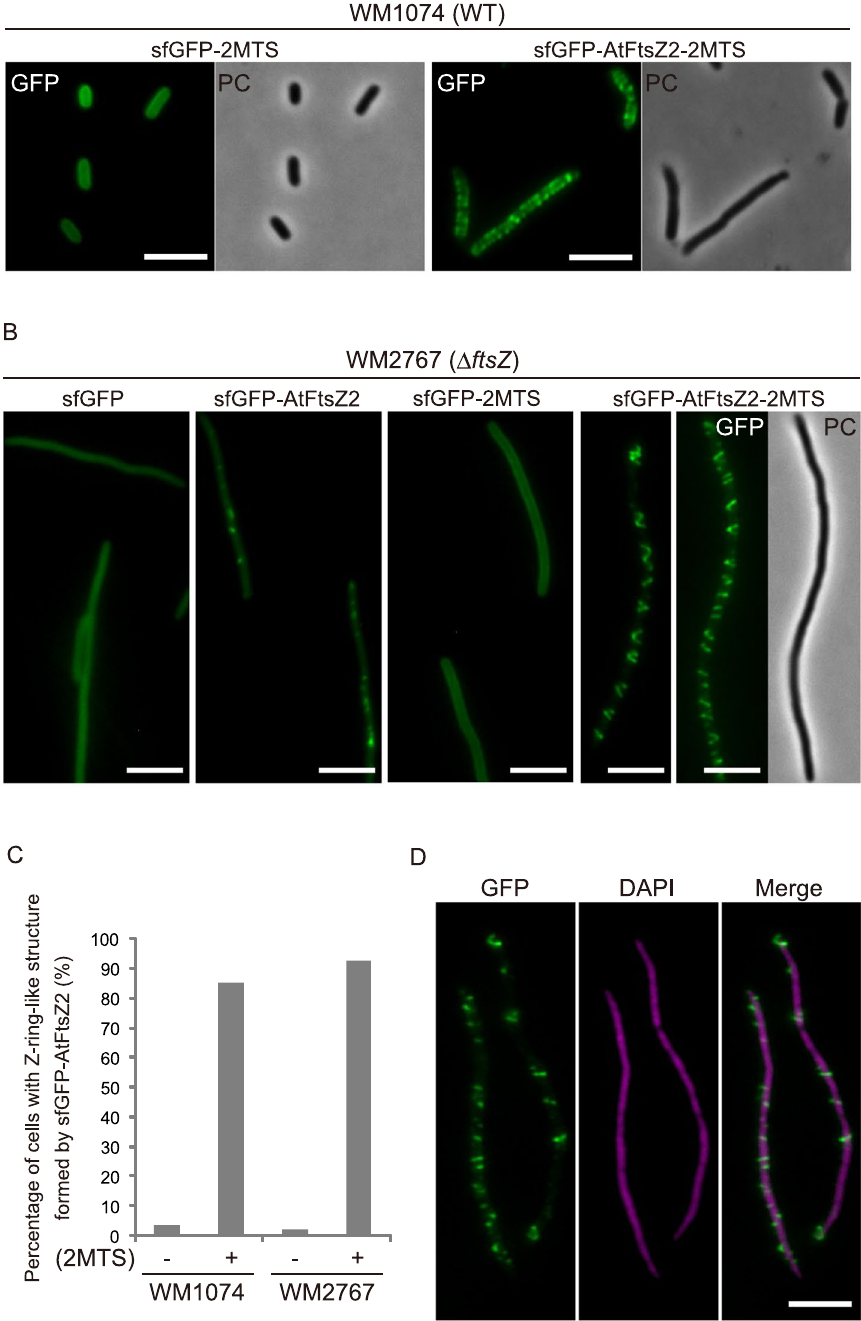
Figure 2. Membrane-tethered FtsZ2 forms multiple Z ring-like structures. ( A ) Fluorescence images of sfGFP- AtFtsZ2 tagged with 2MTS in E. coli WM1074 strain. Scale bar: 5 μ m. ( B ) Filament morphology of sfGFP- AtFtsZ2 with or without 2MTS in the FtsZ-depleted strain WM2767. Scale bar: 5 μ m. ( C ) Quantification of Z ring-like structures formed by sfGFP-AtFtsZ2 with or without 2MTS in the WM1074 and WM2767 strains. The graph shows the percentage of cells containing > 1 Z-ring-like structure. The numbers of elongated bacterial cells investigated for the quantification were 212 (WM1074/sfGFP-AtFtsZ2), 123 (WM1074/sfGFP-AtFtsZ2- 2MTS), 97 (WM2767/sfGFP-AtFtsZ2), and 41 (WM2767/sfGFP-AtFtsZ2-2MTS). ( D ) Concurrent observation of AtFtsZ2 Z ring-like structures and bacterial chromosomes in the WM2767 strain. Chromosomes were stained with DAPI. Scale bar: 5 μ